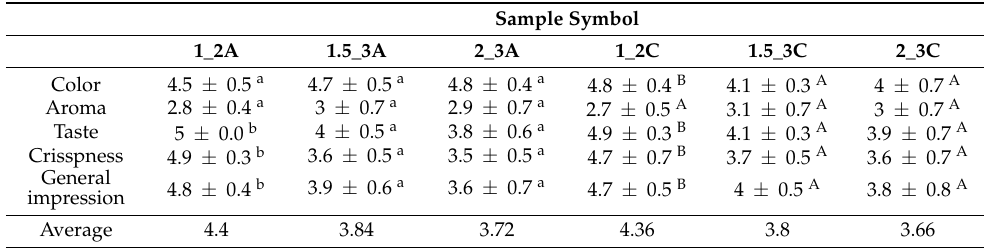
Table 4. The average results of organoleptic evaluation for freeze-dried bars. Denotations in Table 1 include Index (A) next to the sample symbol—bars with the apple pomace, Index (C) next to the sample symbol—bars with the chokeberry pomace. Mean values marked with the same index letter (a,b) do not differ statistically significantly at the level of p = 0.05. The small index letter (a,b) indicates the statistical analysis results for samples with apple pomace whereas the big index letter (A,B) indicates the statistical analysis results for samples with chokeberry